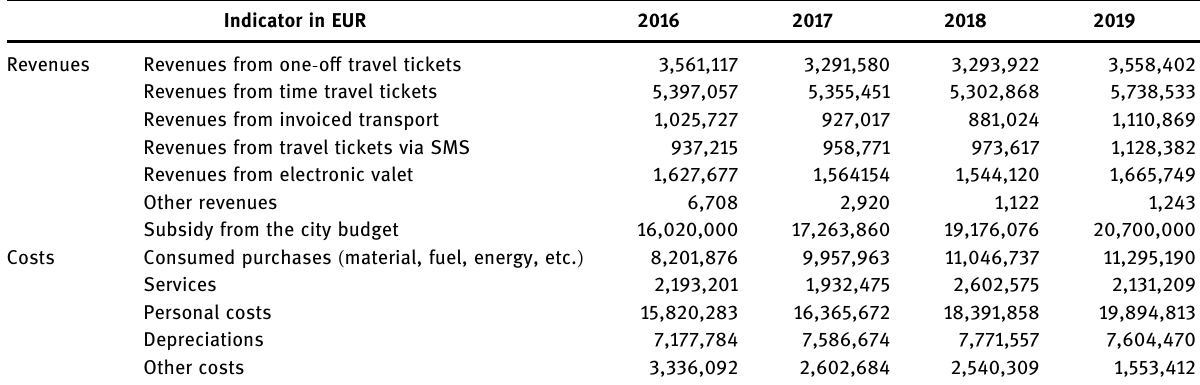
Table 1: Selected revenue and expense items for the period 2016 – 2019 [ 20 ]